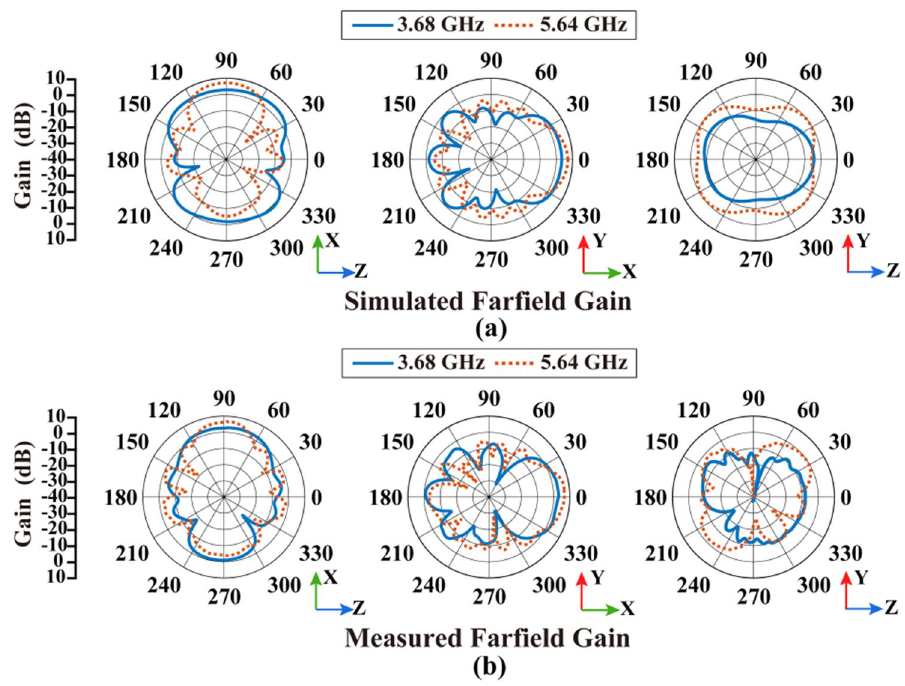
Figure 12. Simulated and measured results of radiation patterns at high frequencies: ( a ) simulated results at 3.68 GHz and 5.64 GHz, ( b ) measured results at 3.68 GHz and 5.64